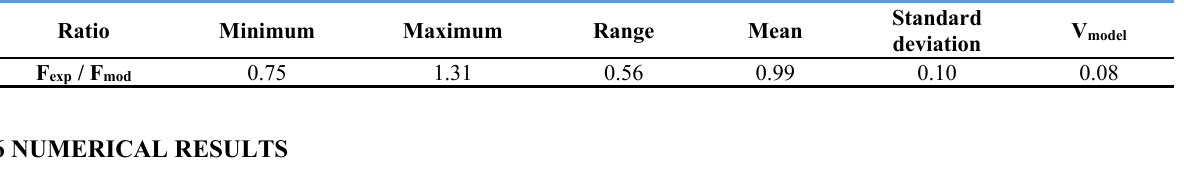
Table 3. Statistical synthesis of results of the validation process.